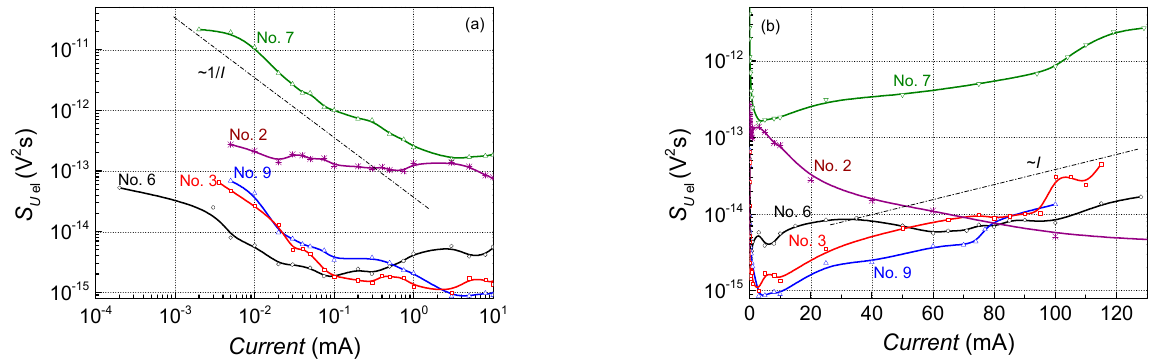
Figure 6. Electrical noise spectral density dependency on forward current at room temperature for